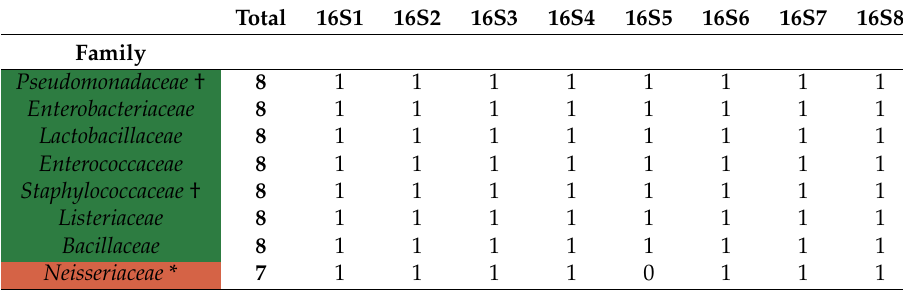
Table 4. Overview of bacteria identified in each gene region for MiSeq data using the NCBI 16S database at different taxonomic levels. The first column lists the taxonomic name at the taxonomic level considered. The second column lists the total number of gene regions where the bacterium was identified. The next columns list the different samples (0 = not detected/1 = detected). Taxonomic names are colored per taxonomic level by a green gradient for bacteria present in the mock community (darker = correctly identified in more samples), and an orange gradient for bacteria not present in the mock community (darker = incorrectly identified in more